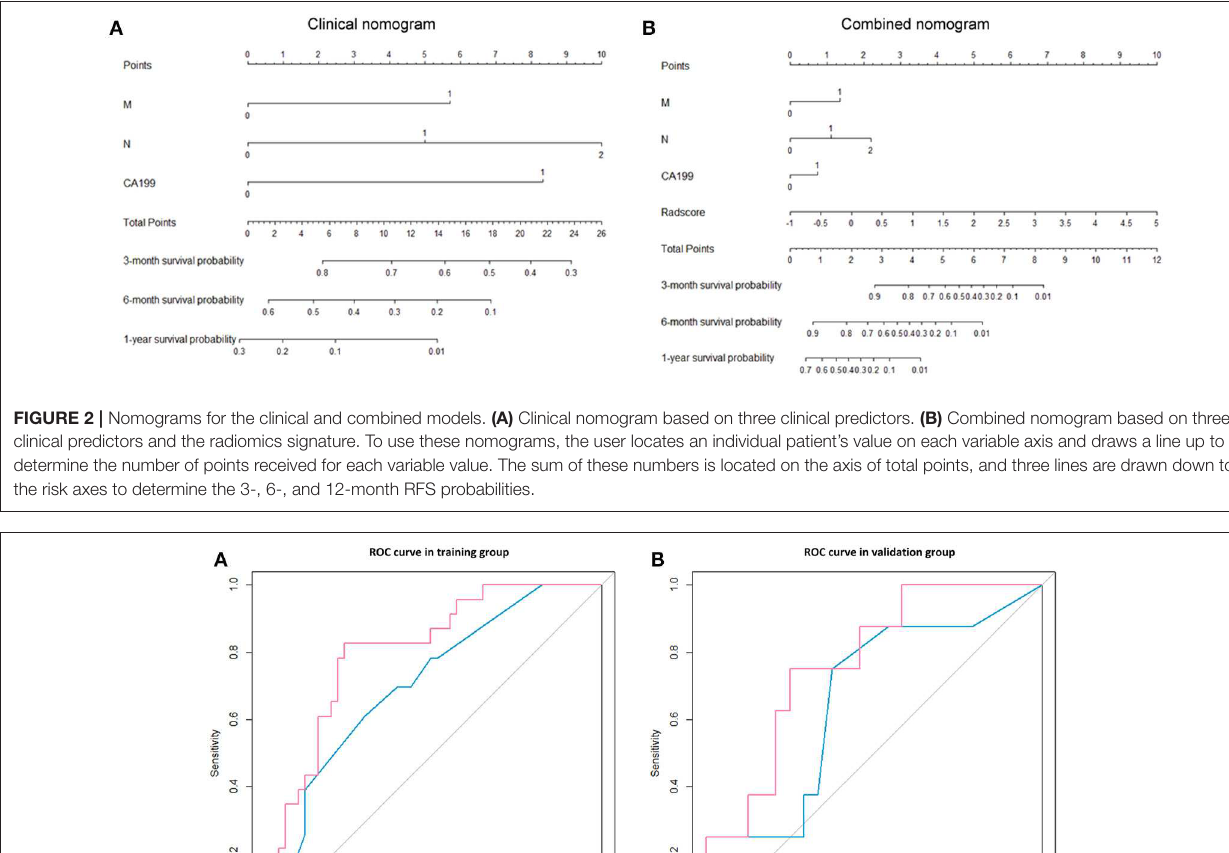
individual can be grouped into a low- or high-risk